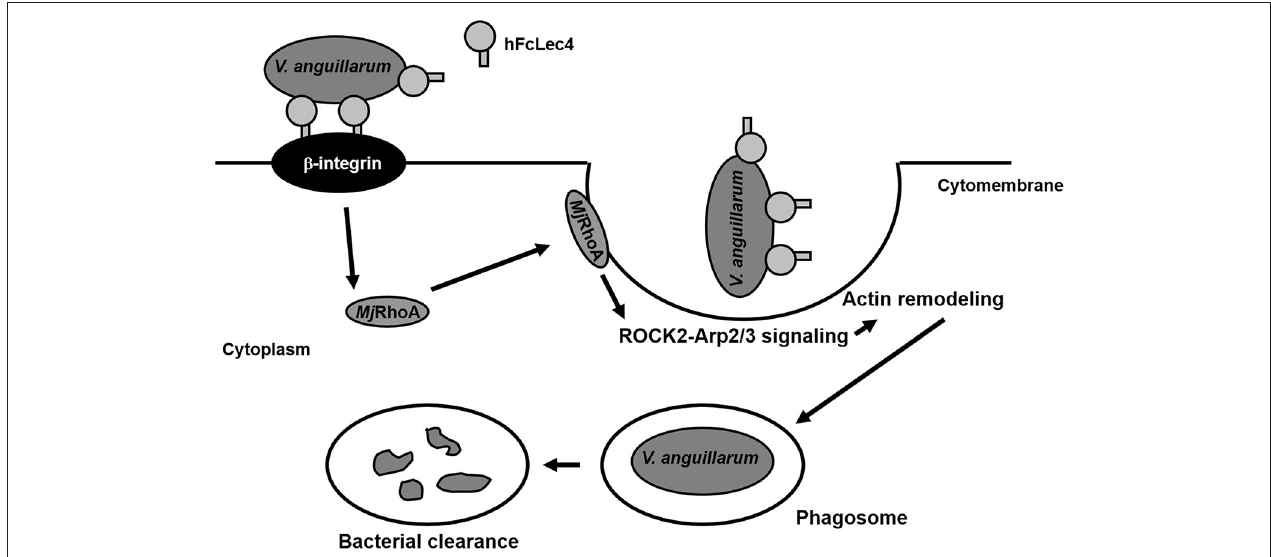
FIGURE 6 | Mj RhoA participates in hFcLec4- β -integrin-mediated phagocytosis in shrimp hemocytes during bacterial infection . FcLec4 homolog serves as a pattern recognition receptor (PRR) and recognizes the infecting bacteria. After binding to the bacterial surface, hFcLec4 activates β -integrin signaling and regulates the expression and subcellular location of downstream Mj RhoA. Activated Mj RhoA is recruited onto the cytomembrane and regulates actin remodeling through the downstream effectors, ROCK2 and Arp2/3. Actin remodeling triggers cell morphological changes and phagosome formation to destroy the